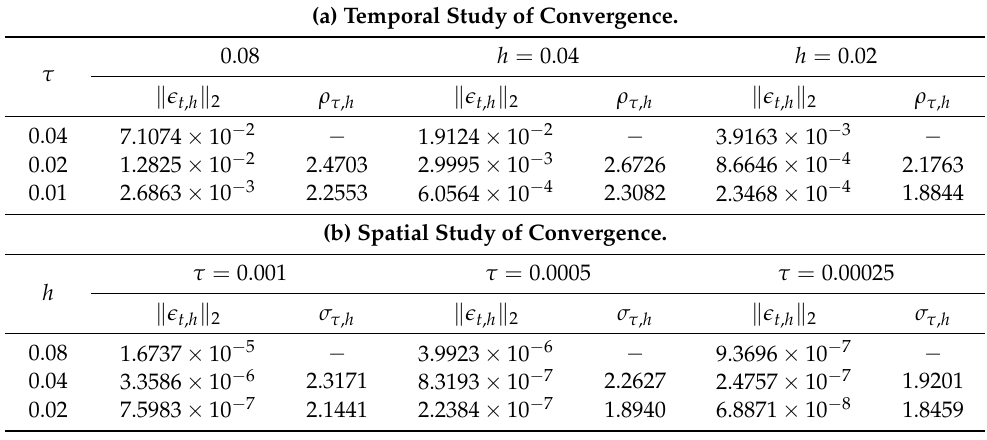
Table 2. Absolute errors and the rates of convergence (a) in time and (b) in space. Example 2 describes the experimental setting for these